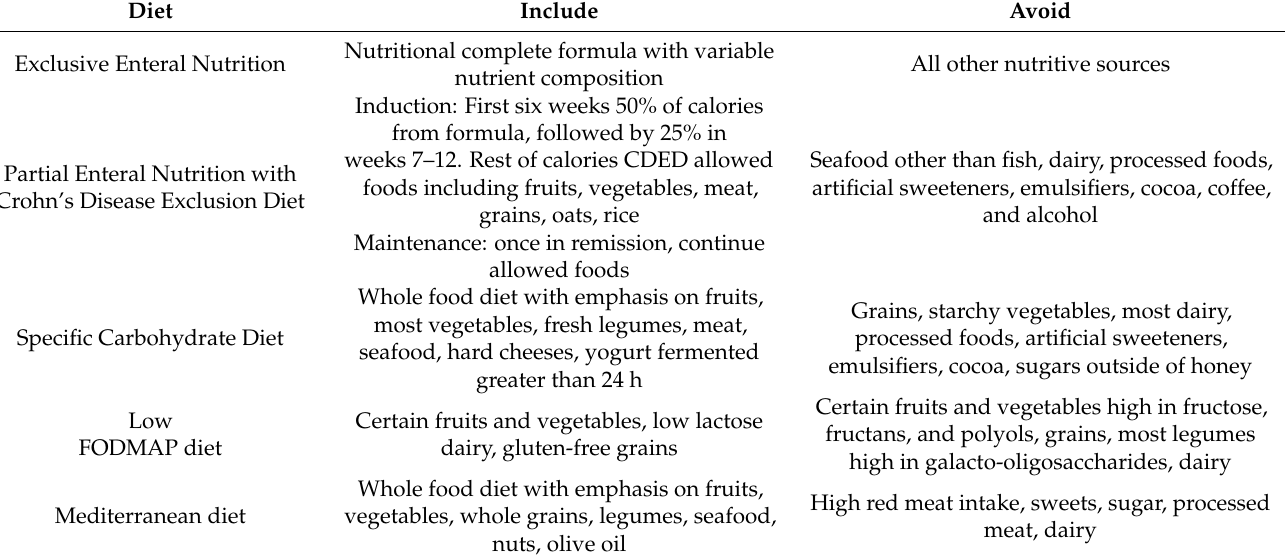
Table 2. Descriptor of dietary interventions for